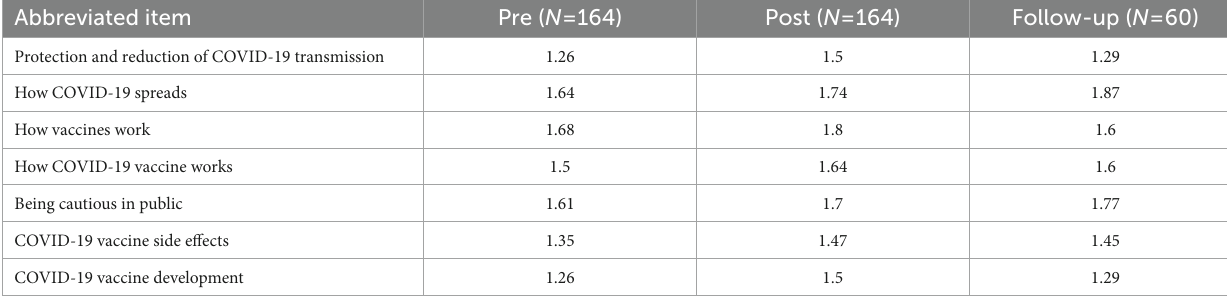
TABLE 5 Mean item virus and vaccine knowledge difference scores for all timepoints.